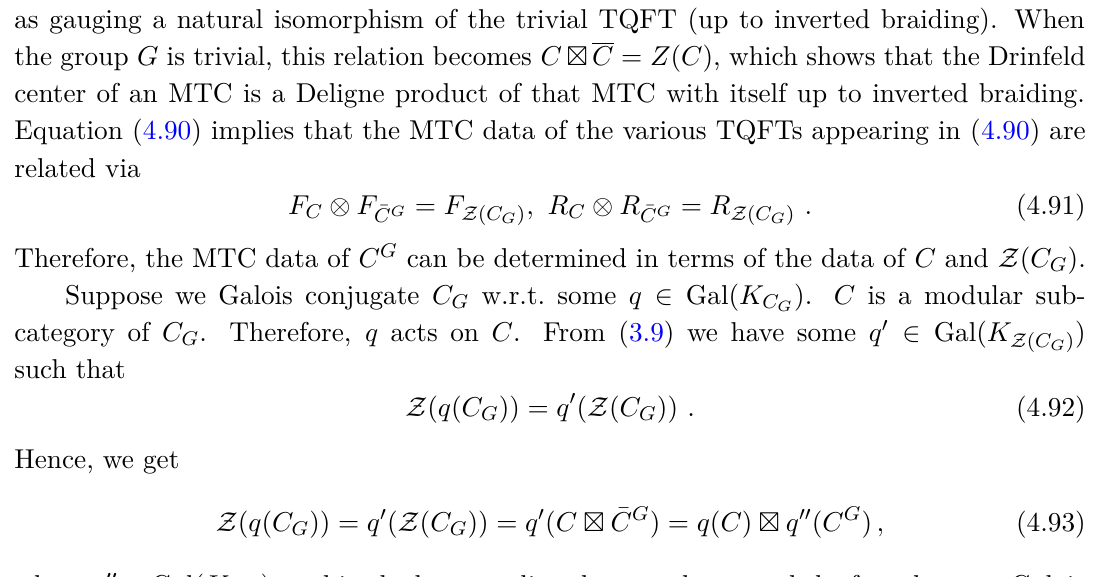
as gauging a natural isomorphism of the trivial TQFT (up to inverted braiding). When the group G is trivial, this relation becomes C (cid:2) C = Z ( C ) , which shows that the